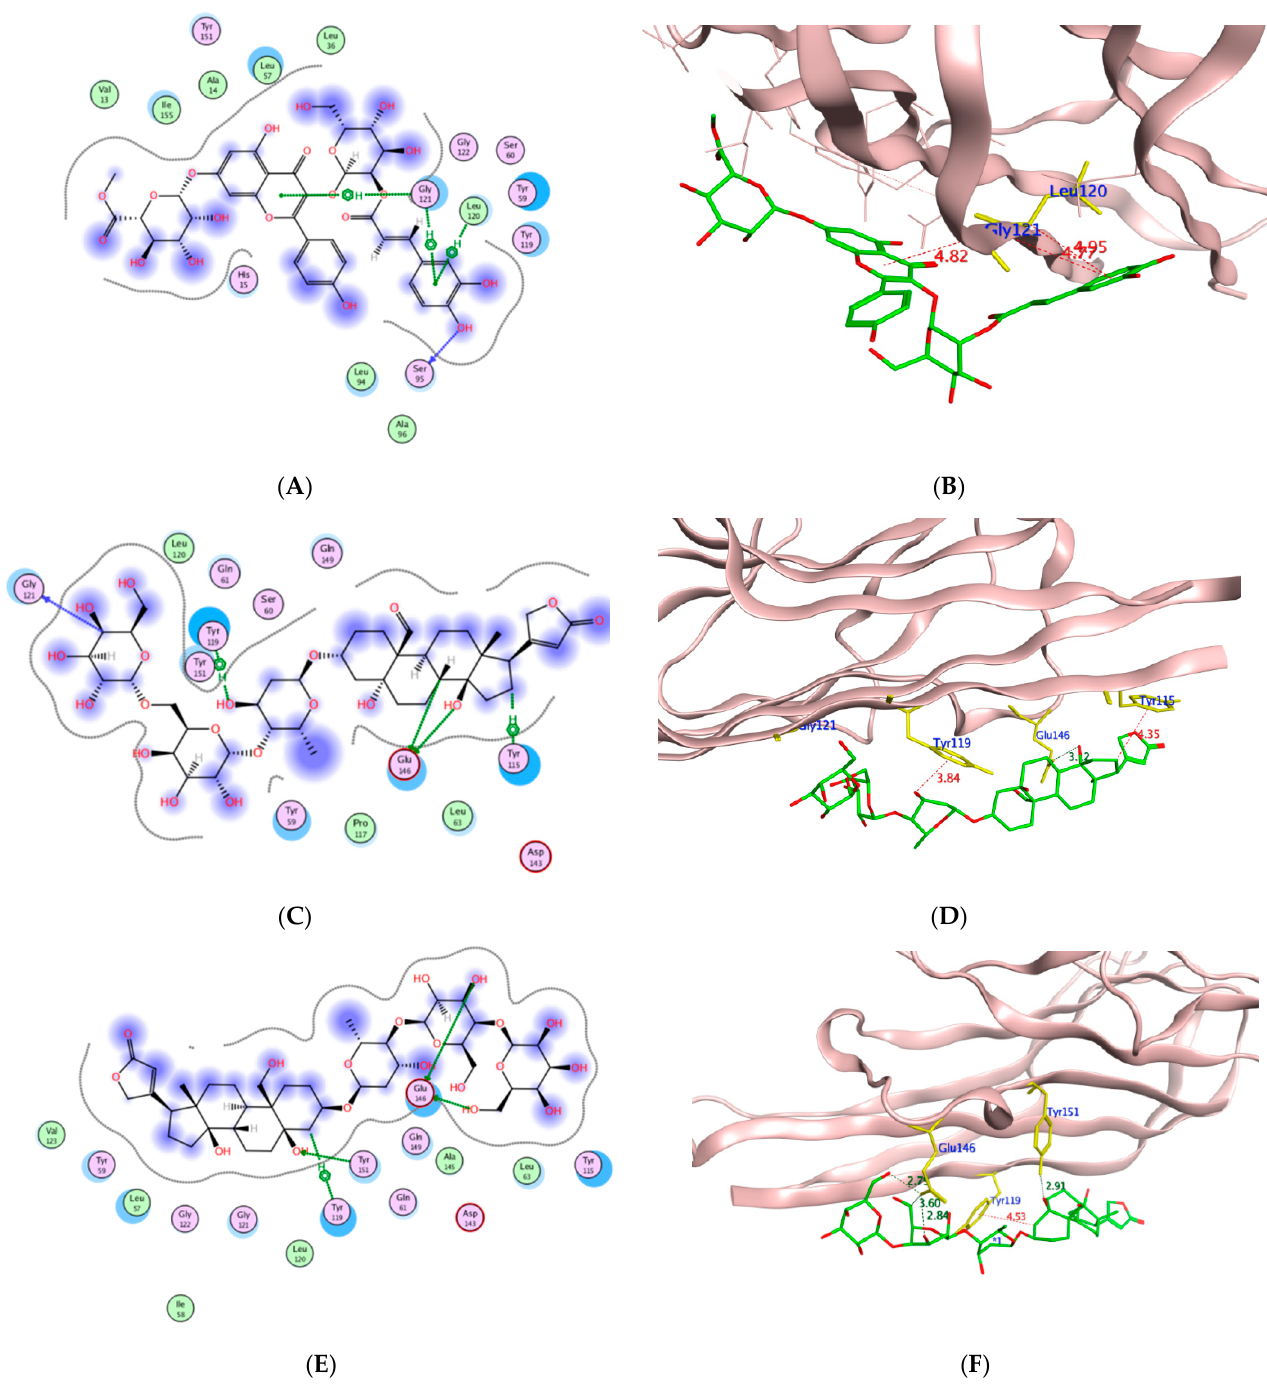
Figure 12. The 2D and 3D molecular docking presentation of the possible binding conformations of 19 ( A , B ), 20 ( C , D ), and 21 ( E , F ) in the TNF- α active site using PDB 2AZ5. The interacting residues are highlighted in the yellow stick model with H-bonds and H-pi interactions are presented as green and red dotted lines, respectively, having their distances illustrated in Å.